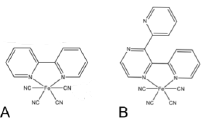
Fig. 1. Chemical structures of (A) [Fe(CN) 4 (bpy)] 2- and (B) [Fe(CN) 4 (bpp)] 2-